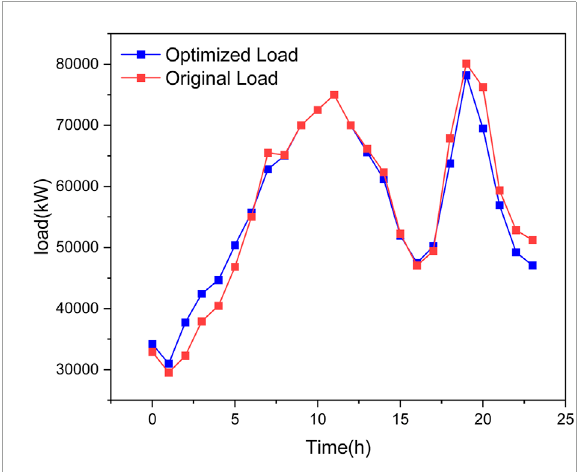
FIGURE 10 Microgrid load curve before and after optimization when there are 1,000 electric